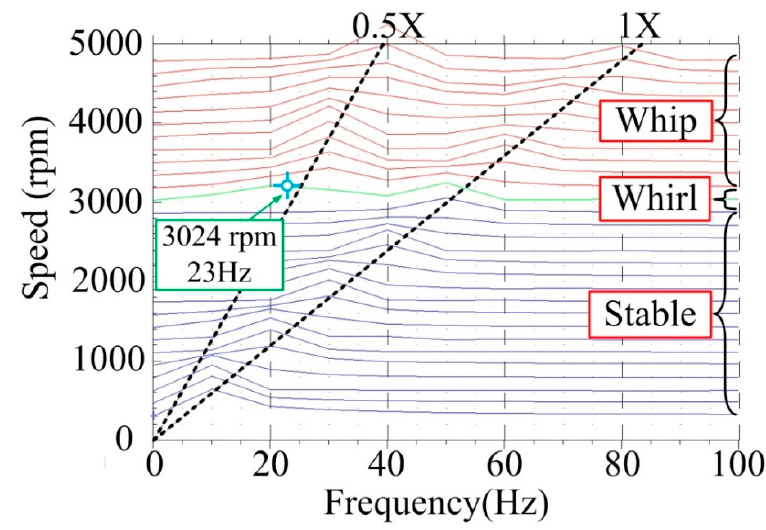
Figure 6. Full spectrum cascade plots of oil bearing without magnetic field.